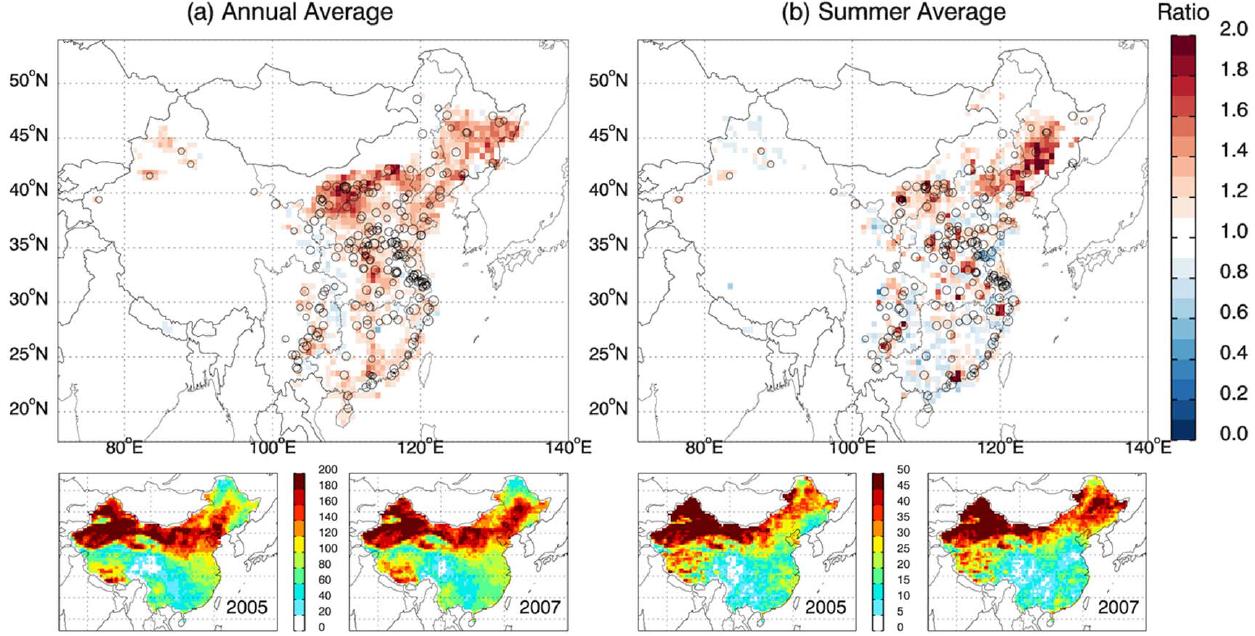
Fig. 7. Ratios of average OMI tropospheric NO 2 columns between 2007 and 2005 using (a) annual averages and (b) summer averages. Only grids inside Chinese boundary and with average NO 2 columns > 1.0 × 10 15 moleculescm − 2 in both years are colored. Open circles denote the new power plants coming into operation during 2005–2007 (only new power plants coming into operation during June 2005–August 2007 are plotted in (b) ), with three sizes from small to large: < 500MW, 500–1200MW, > 1200MW. Small maps below each ratio map present the sample amounts used in the averages for the corresponding years (note change of scale).